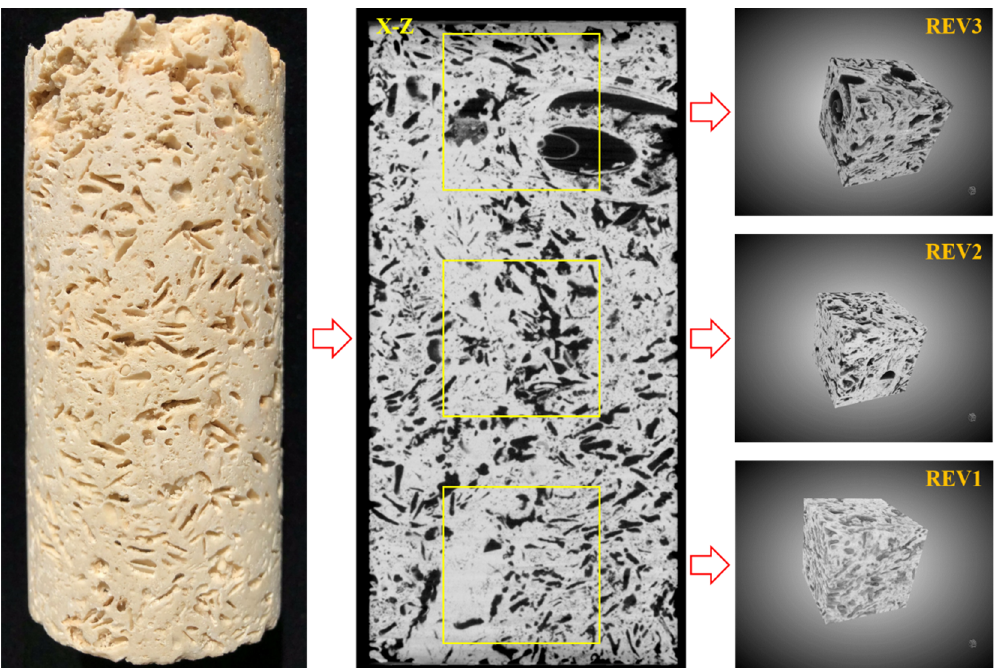
Figure 8. Representative elementary volumes (REV) that are chosen for each test sample.